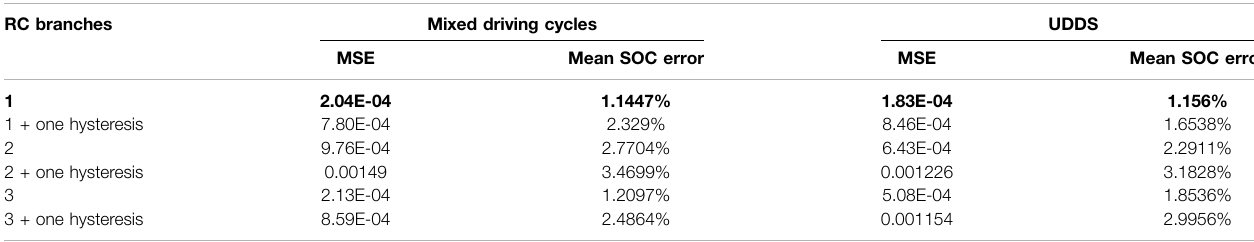
TABLE 13 | H-in fi nity fi lter with 1% current bias noise added.